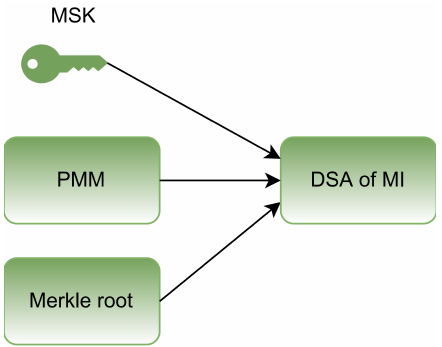
Figure 9. The proposed digital